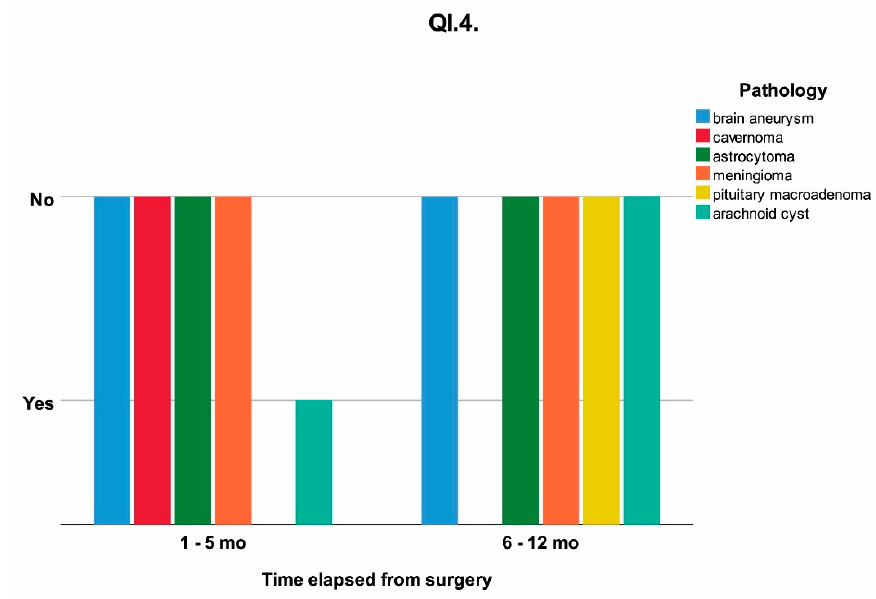
Figure 3. The response at QI.4 (“Did you experience, during/after the healing period, any pain in the anterior region of the ear?”) influenced by the time elapsed from surgery clustered on the initial pathology; mo = months.